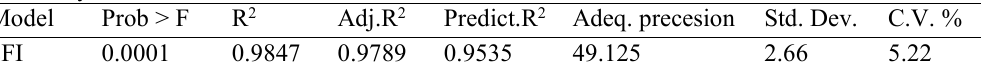
Table 3. Results of linear regression analysis for 2FI model in RSM for azithromycin removal using